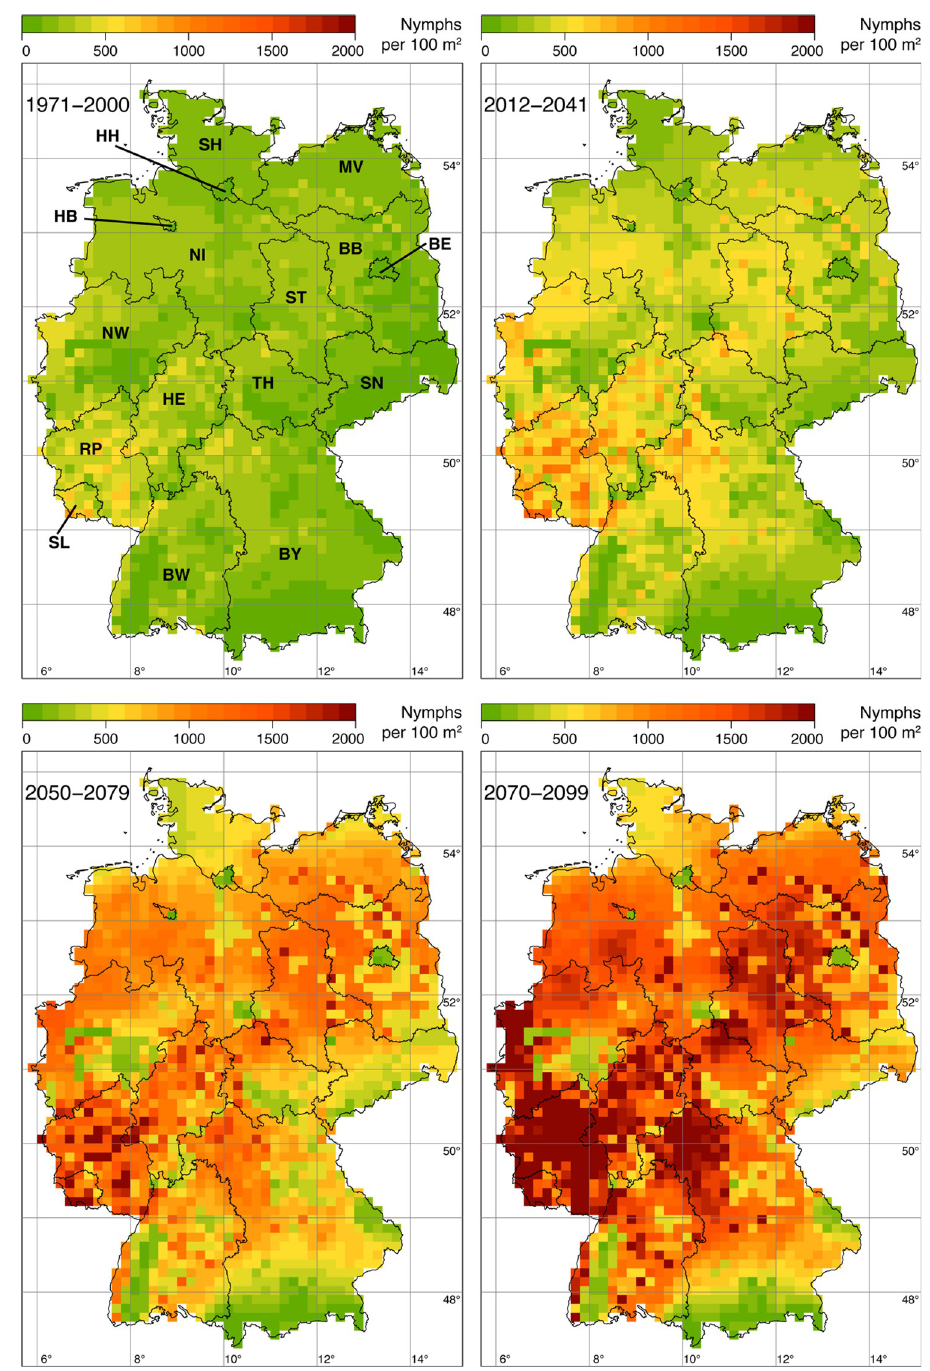
Fig 8. Ensemble means of nymphal I . ricinus density for the reference period (top left), the near-term scenario (top right), the mid-term scenario (bottom left), and the long-term scenario (bottom right). We set a threshold of 2,000 nymphs / 100 m 2 which is twice the maximum currently observed annual nymph density in Germany (O. Kahl 2021, pers. comm.). Note that the given density of nymphs / 100 m 2 should be interpreted as the annual number of I . ricinus nymphs, which one would collect by monthly flagging an area of 100 m 2 . The abbreviations in the map at the top left indicate the names of the federal states of Germany (BW: Baden-Wu¨rttemberg, BY: Bavaria, BE: Berlin, BB: Brandenburg, HB: Bremen, HH: Hamburg, HE: Hesse, NI: Lower Saxony, MV: Mecklenburg-Vorpommern, NW: North Rhine-Westphalia, RP: Rhineland-Palatinate, SL: Saarland, SN: Saxony, ST: Saxony-Anhalt, SH: Schleswig- Holstein, TH: Thuringia). State and federal state boundaries were taken from the GADM, the database of global administrative areas (https://gadm.org).